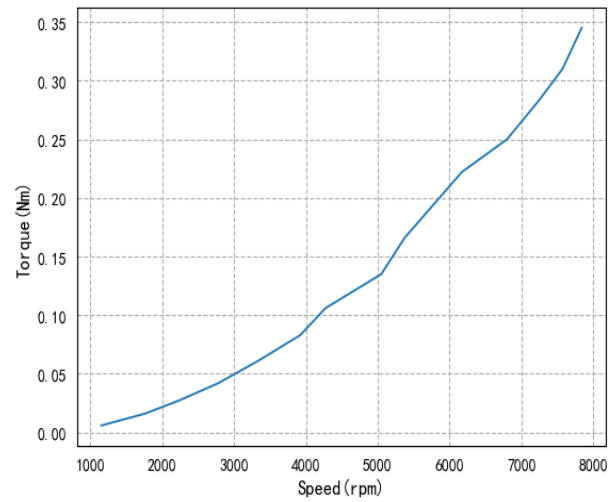
Figure 7. Torque–speed curve of cooling fan.